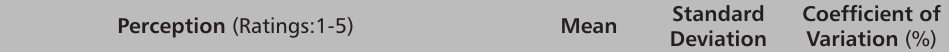
TABLE 5. Perspectives of climate change and fire suppression to fir forests